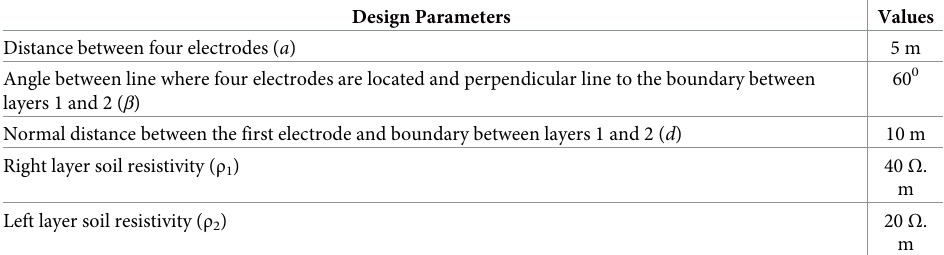
Table 7. Soil properties of vertical two-layer soil structure.